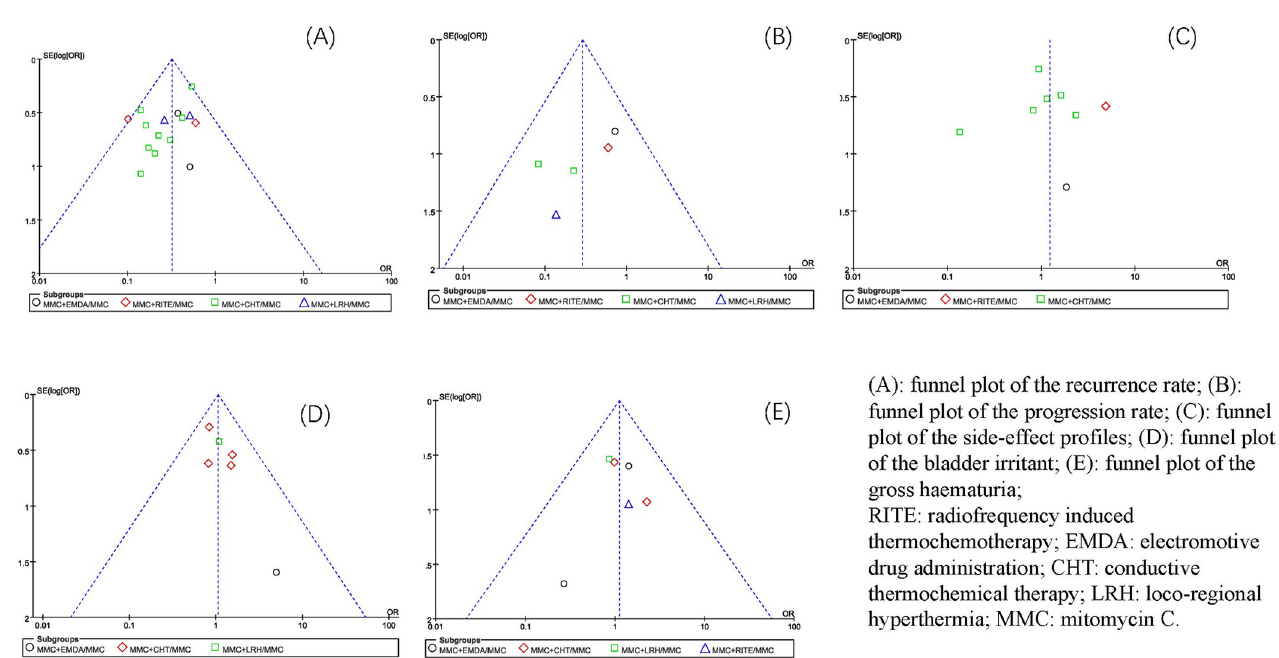
Fig 9. Funnel plots for the publication bias of the included studies based on different outcome indicators.